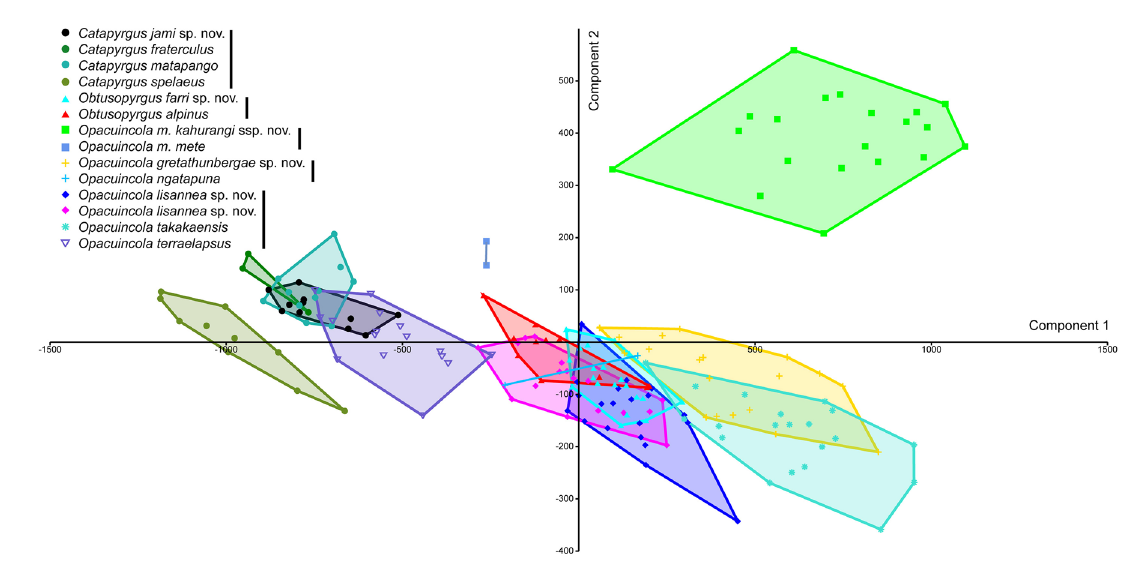
Fig. 3. Shell morphology. Principal component analysis based on five shell measurements of Table